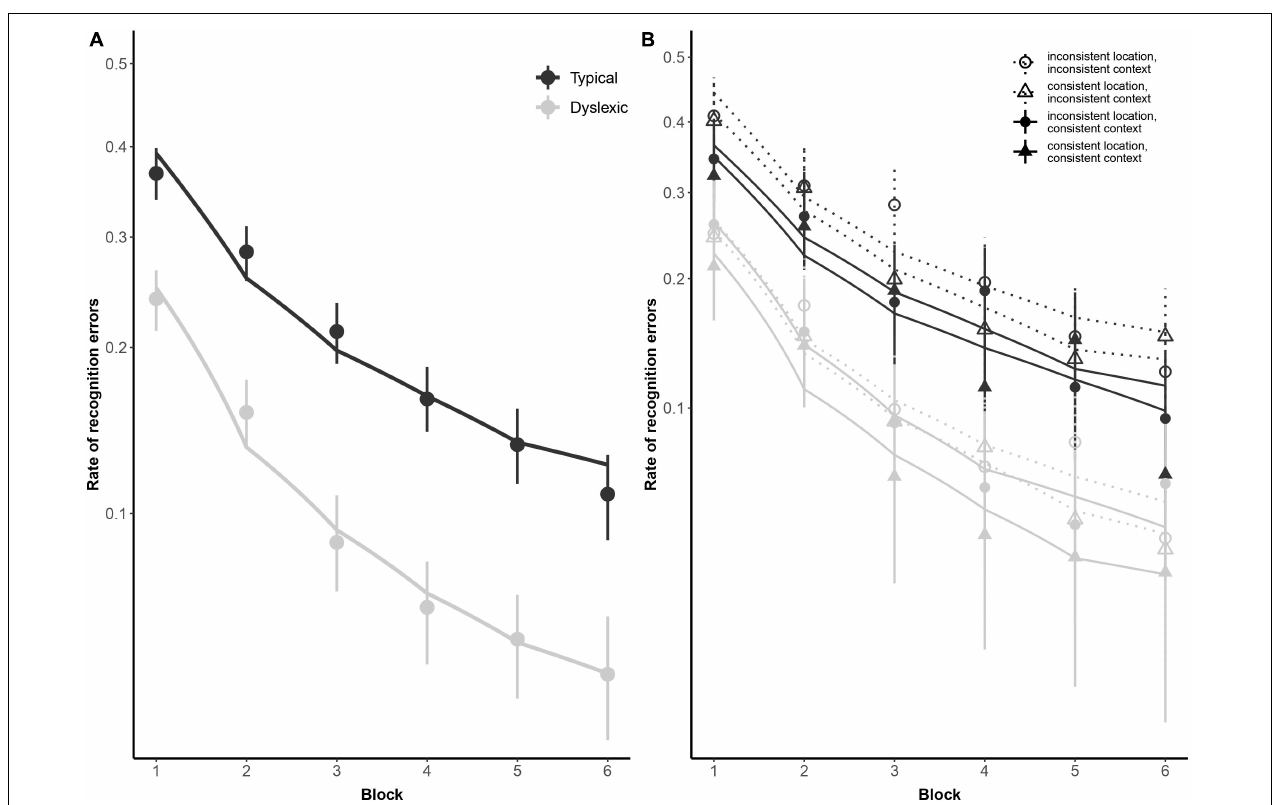
FIGURE 2 | Subject-weighted mean recognition error rates as a function of reading ability and repetition in the training and recognition task. Panel (A) depicts overall recognition error rates for readers with dyslexia and typical readers, whereas panel (B) outlines the same data broken down by trial type (i.e., whether context and/or location was kept consistent during encoding). The y -axis is logit-scaled in both plots to match logistic regression error analyses. Point ranges represent bootstrapped confidence intervals, and lines represent logistic regression model